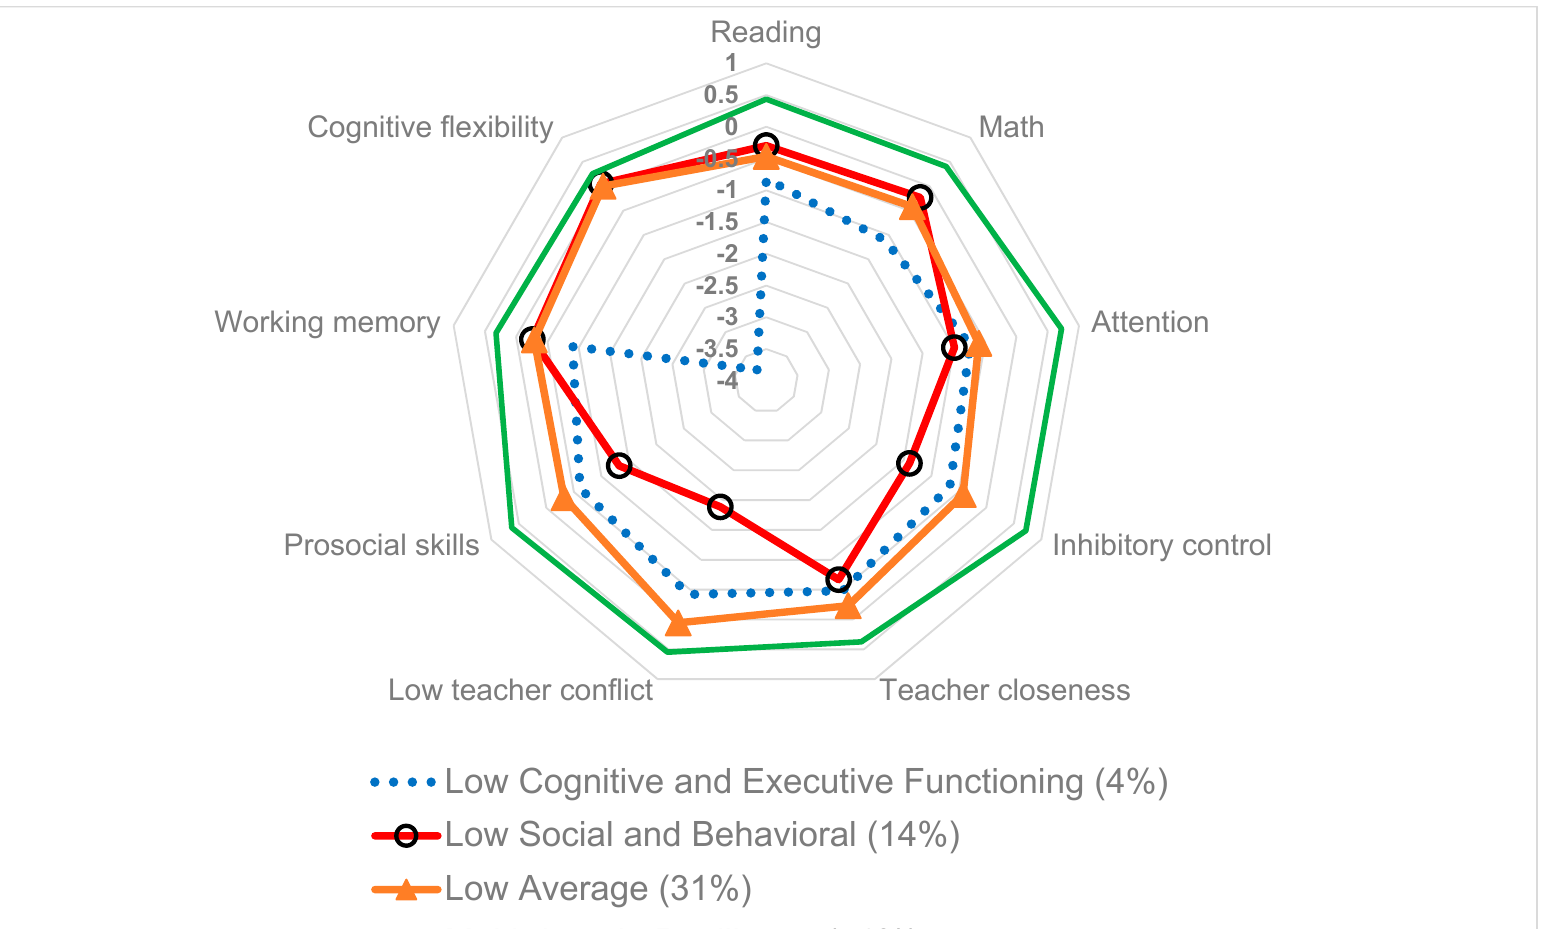
Figure 2. Radar Plot of Latent Profiles of Resilience.